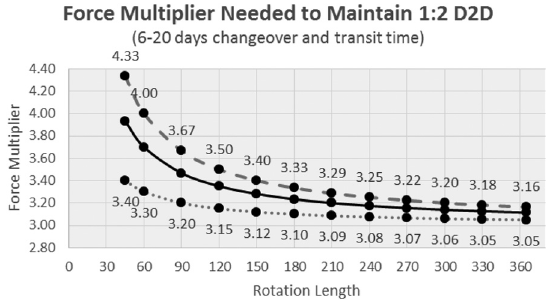
Figure 9. Sensitivity analysis: Force multiplier bounds (6-20 days changeover